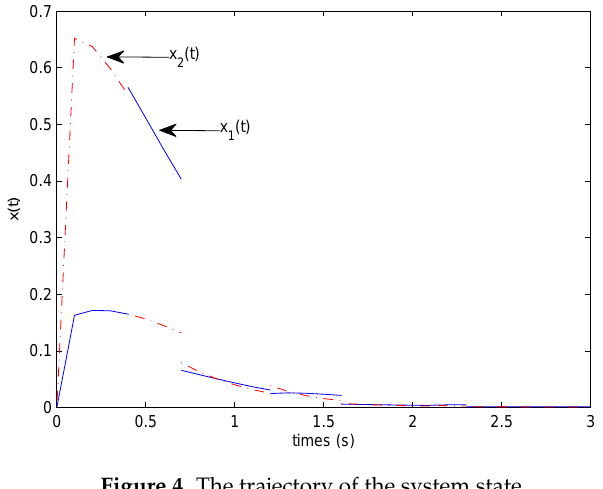
Figure 4. The trajectory of the system state.